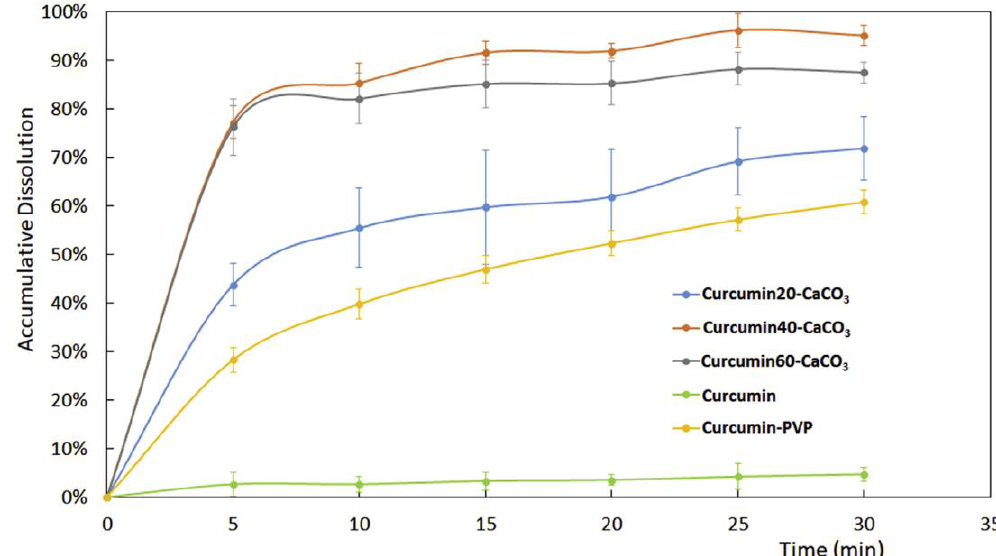
Figure 3. Dissolution profiles of curcumin from pure curcumin, curcumin-CaCO 3 samples with increasing drug loadings and curcumin-PVP solid dispersion. Reprinted with permission from Ref. [29] 2019, Elsevier.